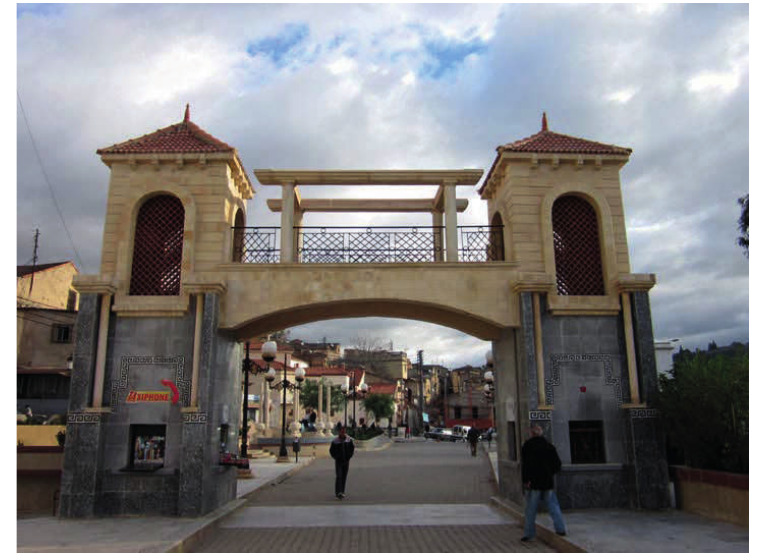
Fig. 9. Monumental doors in the place of Kerkeri (Place Kerkeri, n.